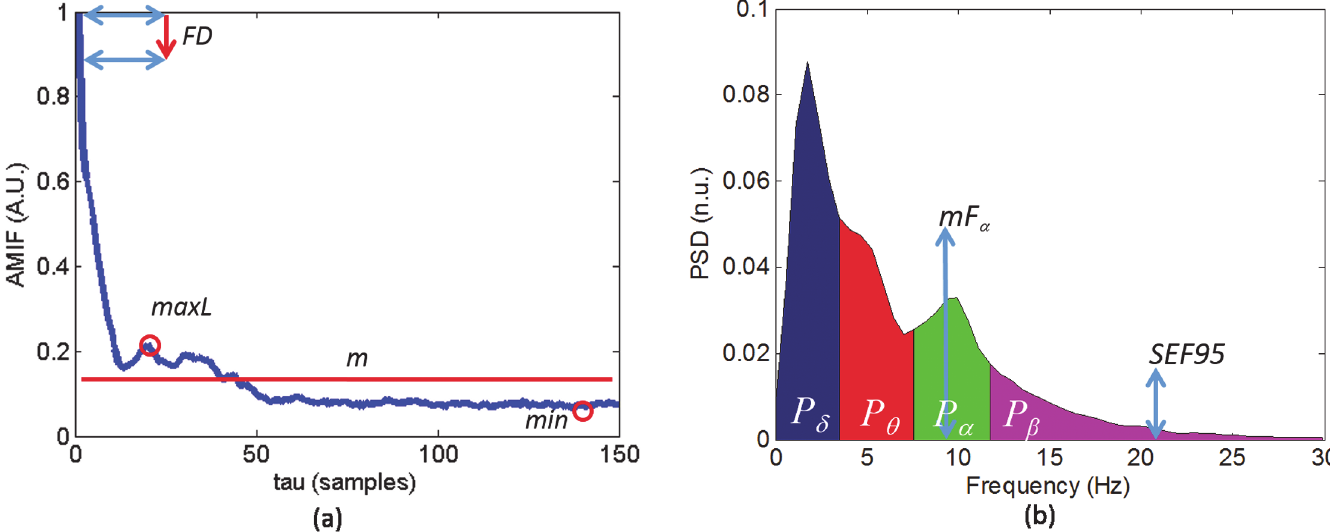
Fig 3. Measures extracted from Auto-Mutual Information Function (AMIF) and Power spectral density (PSD). Example of the measure calculation from (a) AMIF and (b)